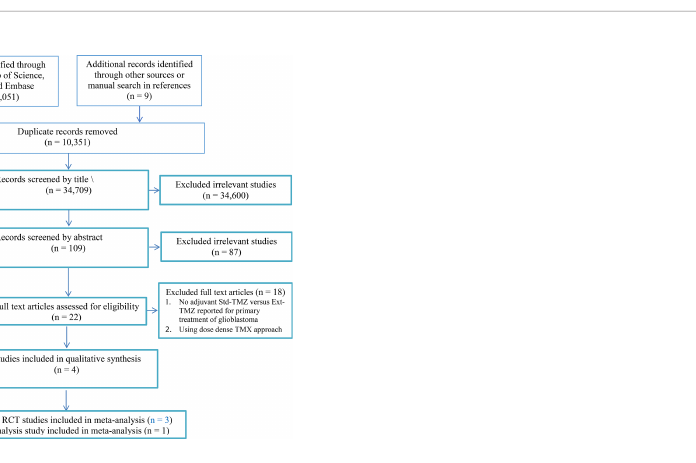
FIGURE 1 | The PRISMA fl ow diagram. Three out of four eligible studies were randomized comparisons of adjuvant std-TMZ versus ext-TMZ for primary treatment of glioblastoma (19, 20, 23).The remaining study was a pooled analysis of four RCTs (26). The main characteristics of the eligible studies are shown in Table 2 .